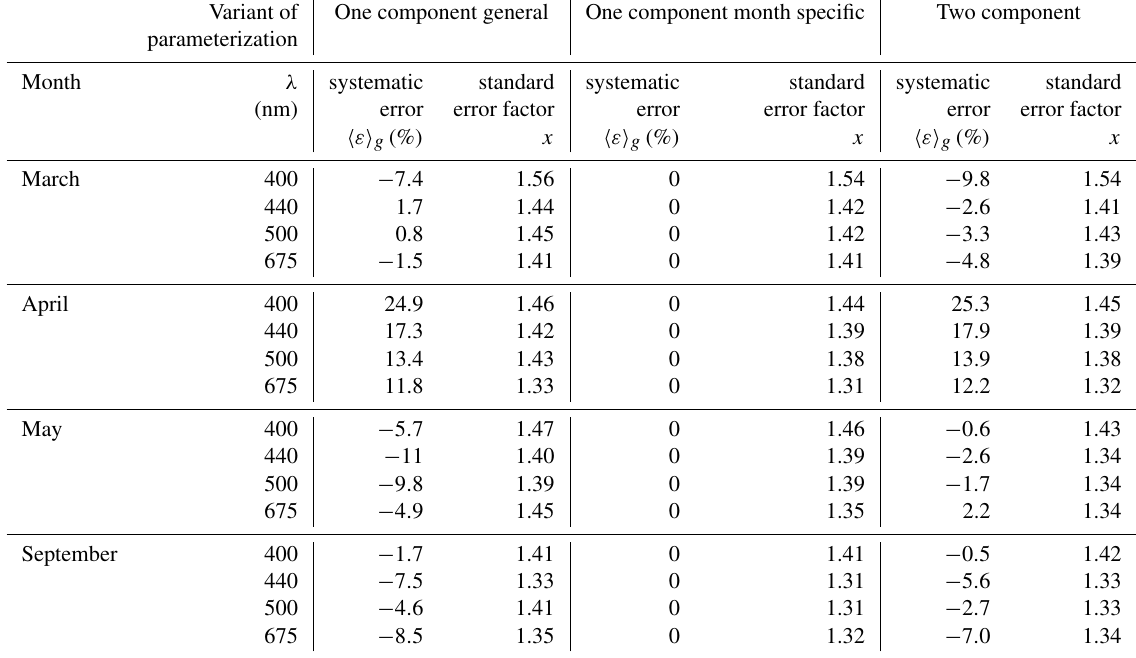
Table 4. Selected characteristics of the estimation error logarithmic statistics calculated according to different parameterizations and for particular months: March, April, May and September (the numbers of data considered were 174, 96, 201 and 211, respectively). Variant